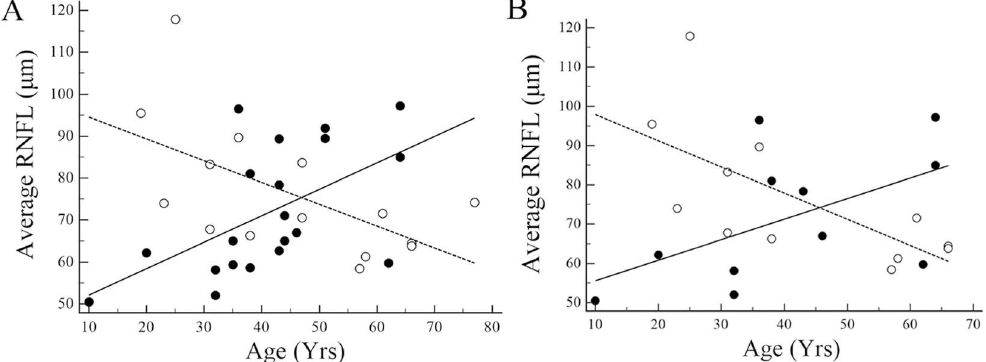
Fig 3. Associations of circumpapillary retinal nerve fiber layer (RNFL) averagethickness with age in all eyes(A) and eyeswith a single episode of optic neuritis (B). Opencircles anddottedlinesindicateeyes with aquaporin-4 antibody (AQP4 Ab)-negativeoptic neuritis,whereasclosedcirclesandsolidlinesindicateeyes with antibody-positiveoptic neuritis.Spearmanrank correlationcoefficients (95%confidenceinterval,P-value)for the AQP4 Ab-negative and-positivegroupswere-0.57(-0.84to -0.08,0.03) and0.63 (0.27to 0.84, 0.003),respectively, in the all eyes(A), and-0.74 (-0.92to -0.28, 0.006)and0.67 (0.12to 0.91, 0.024),respectively, in eyeswith a single episodeof optic